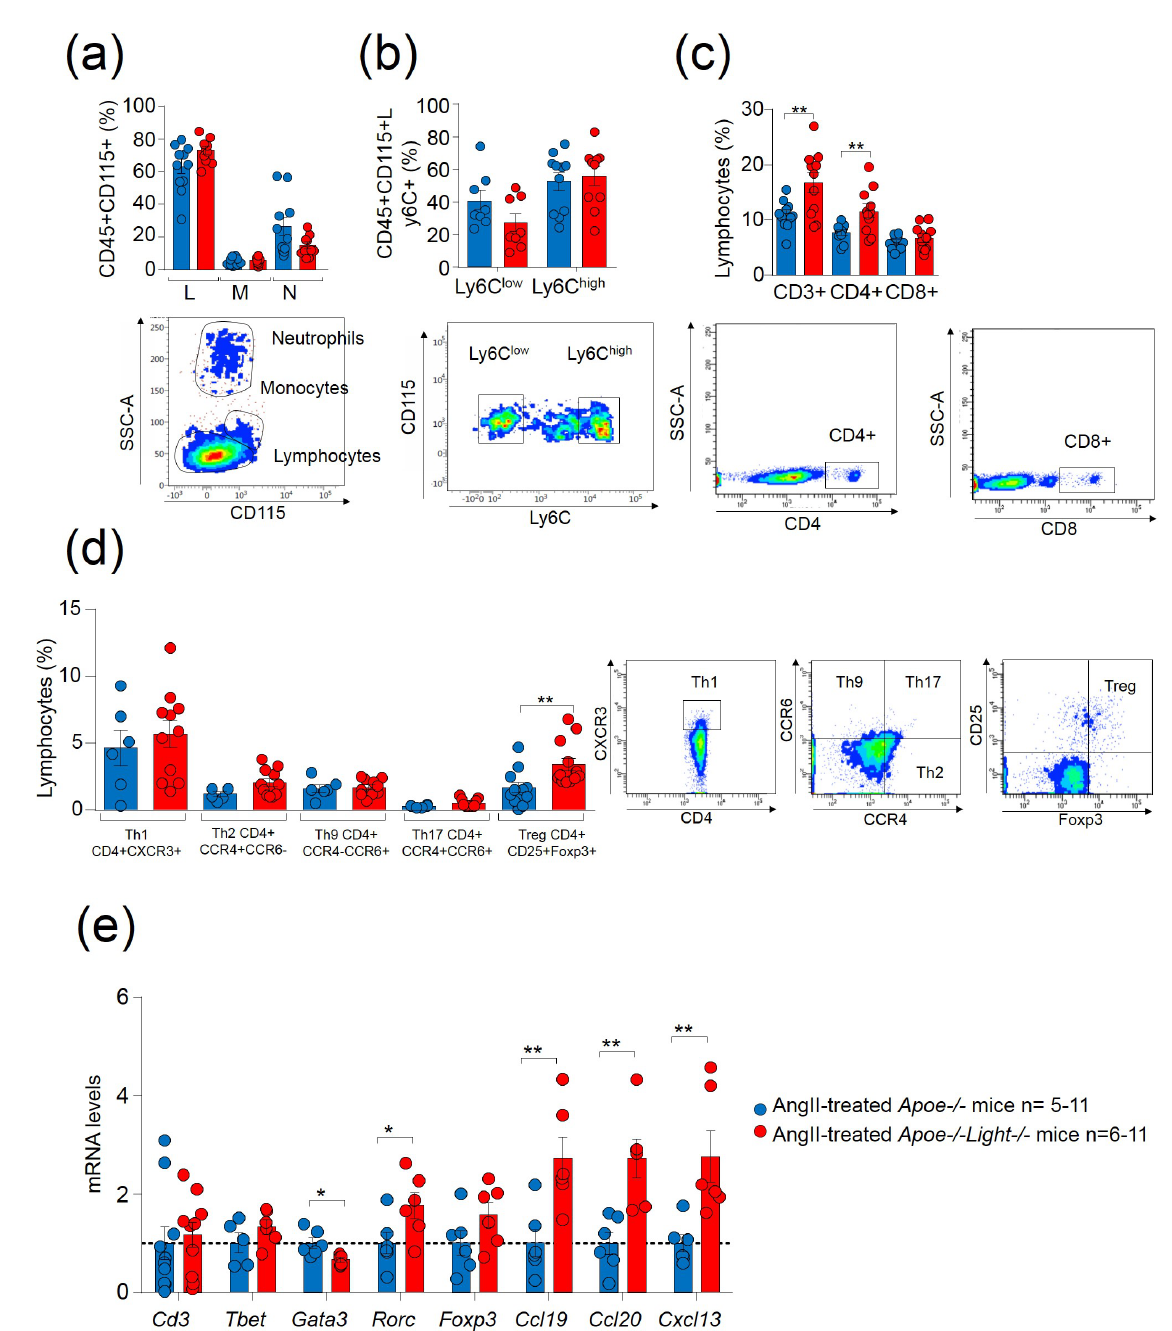
Figure 2. Analysis of inflammation in AngII–induced dissecting AAA in Apoe − / − and Apoe − / − Light − / − mice. ( a ) Percent- ages of circulating lymphocytes, L, monocytes, M, and neutrophils, N, identified in the CD45 + blood cell population by morphology and by the CD115 monocyte marker in AngII–treated Apoe − / − and Apoe − / − Light − / − mice. ( b ) Percentages of monocyte subsets CD45 + CD115 + Ly6C low and CD45 + CD115 + Ly6C hi identified within the CD45 + CD115 + population in all groups of mice. ( c ) Circulating levels of CD3 + , CD4 + , and CD8 + lymphocytes in mice. ( d ) Cellular subpopulations within CD4 + T lymphocytes: CD4 + CXCR3 + Th1, CD4 + CCR4 + CCR6 − Th2, CD4 + CCR4 − CCR6 + Th9, CD4 + CCR4 + CCR6 + Th17, and CD4 + Foxp3 + CD25 + Treg for both mice groups. Representative flow cytometry plots of the gating strategies are displayed. ( e ) mRNA levels of Cd3 , Tbet , Gata3 , Rorc and Foxp3 genes in aneurysmal tissue from AngII-treated mice. mRNA levels were normalized to Cyclophilin mRNA levels and relativized to AngII-treated Apoe − / − mice. Statistical analysis was performed using Student’s t test ( a – e ) and Mann–Whitney U test (in ( d ) for Th17 and Treg cells). * p ≤ 0.05 and ** p <